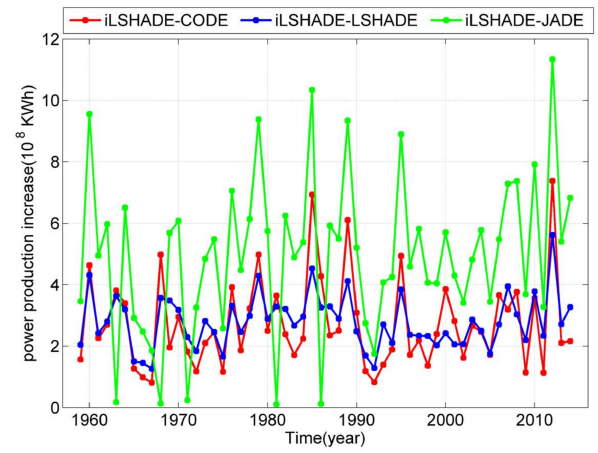
Figure 8. Historical runoff data from 1959 to 2014 for the annual power production increase that iLSHADE compares to LSHADE, JADE and